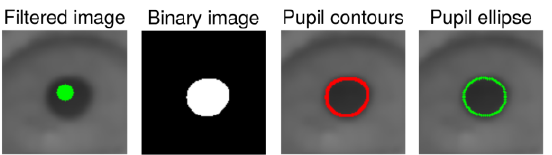
Figure 6. From left to right: the low-pass filtered image with the estimated pupil center (see Section 2.2); the bi- narized image; the filtered image with detected pupil contours, defined as the edges of the blob in the binarized image that contains the estimated pupil center; and the pupil ellipse that is fitted to the